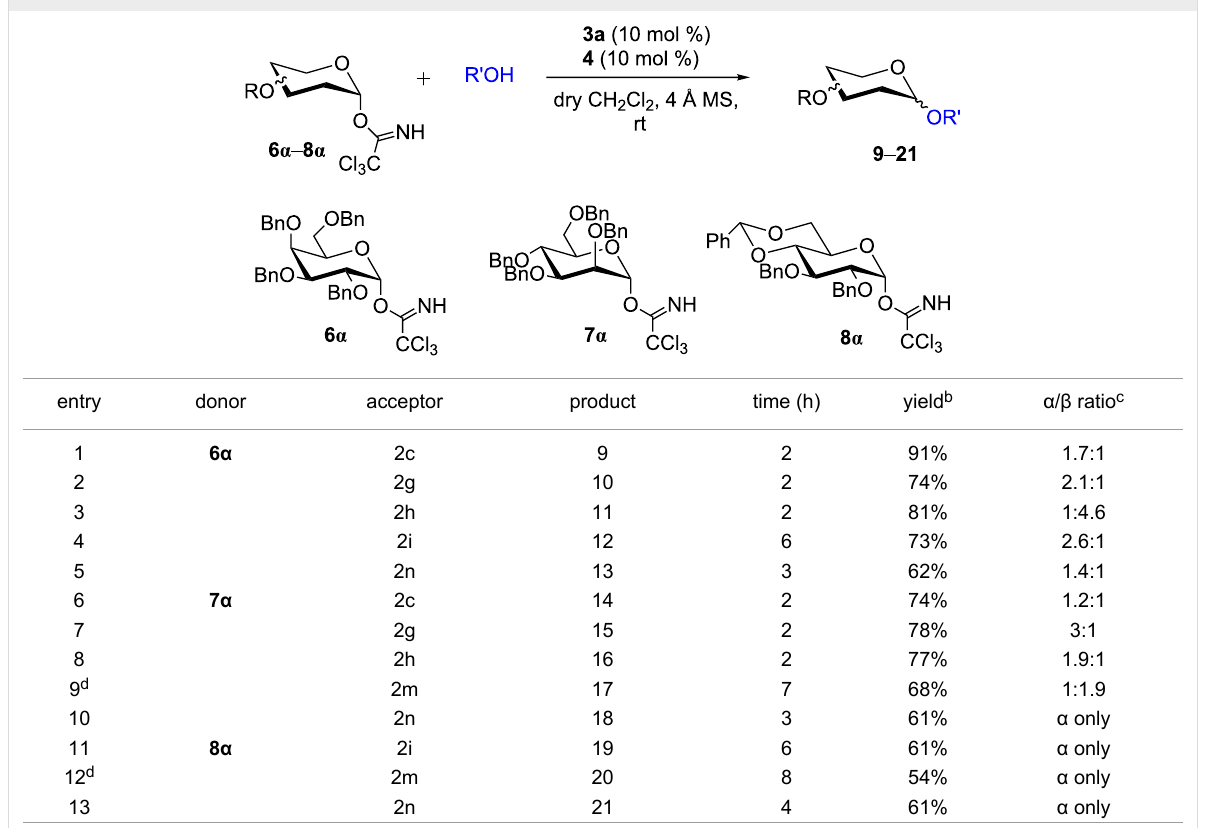
Table 3: Glycosylation of donors 6 α – 8 α with variety of acceptors a